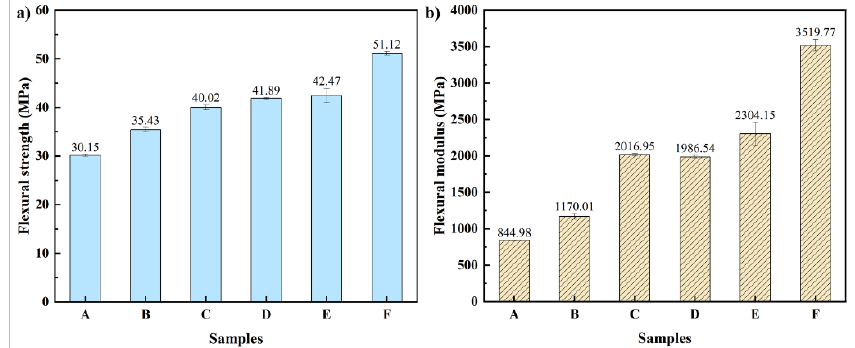
Figure 5. ( a ) Flexural strength and ( b ) flexural modulus of the